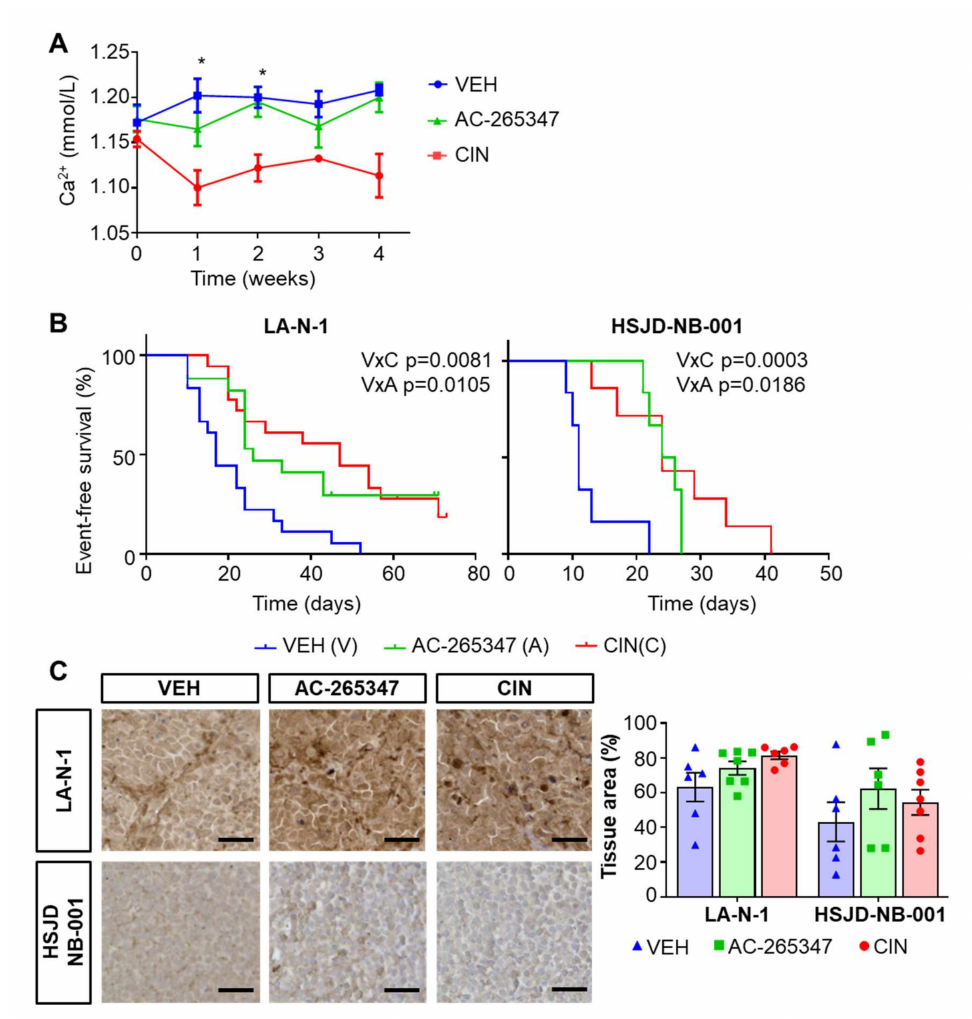
Figure 1. AC-265347 delays NB tumor growth while maintaining plasma calcium levels. ( A ) Healthy athymic mice were treated with 10 mg/kg of AC-265347, CIN or their vehicle ( n = 5). Blood samples were collected from tail vein and ionised plasma calcium concentration (mmol/L) was measured weekly. Each point represents mean ± SEM of each group. Statistical significance was calculated using One-way ANOVA with Dunn’s correction. * p < 0.005. ( B ) Event-free survival (EFS) rates of mice bearing LA-N-1 xenografts ( n = 17) or HSJD-NB-001 ( n = 6) treated with 10 mg/kg of AC-265347, CIN or their vehicle. Log-rank statistics with a Bonferroni correction test was used to compare statistical significance between groups (LA-N-1: p = 0.0186, VEH vs. AC-265347; p = 0.0003, VEH vs. CIN; p = 1, CIN vs. AC-265347; HSJ-NB-001: p = 0.0105, VEH vs. AC-265347; p = 0.0081, VEH vs. CIN; p = 1, CIN vs. AC-265347). ( C ) Left: Formalin-fixed, paraffin-embedded sections of LA-N-1 and HSJD-NB-001 tumors exposed to treatment were stained with anti-CaSR. Right: Images were acquired with TissueFAXS at × 20 magnification and percentage of positive area per tumor was quantified using STRATA Quest. Statistical analysis between groups was calculated using a Mann–Whitney test ( p > 0.05 for all the comparisons). Each symbol represents an individual tumor and bars represent mean ± SEM. Scale represents 100 µ